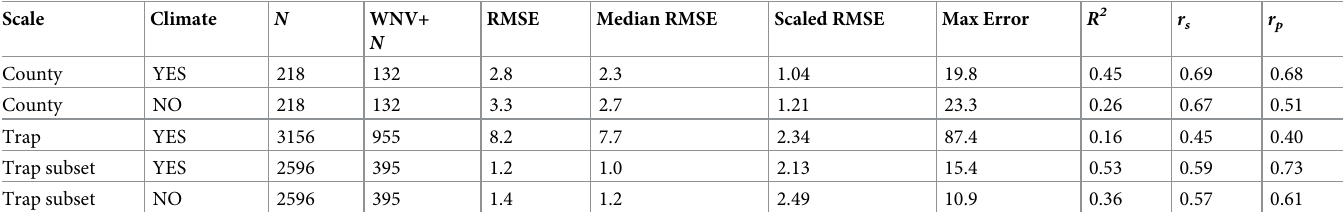
Table 2. Model fit results for the calculated mosquito infection rates (per 1000). Climate indicates whether climate variables were included, N indicates sample size, while WNV+ N indicates the number of samples estimated to have WNV present. RMSE, Median RMSE, Max Error, Scaled RMSE, R 2 , r p , and r s are defined in Methods : model fit statistics